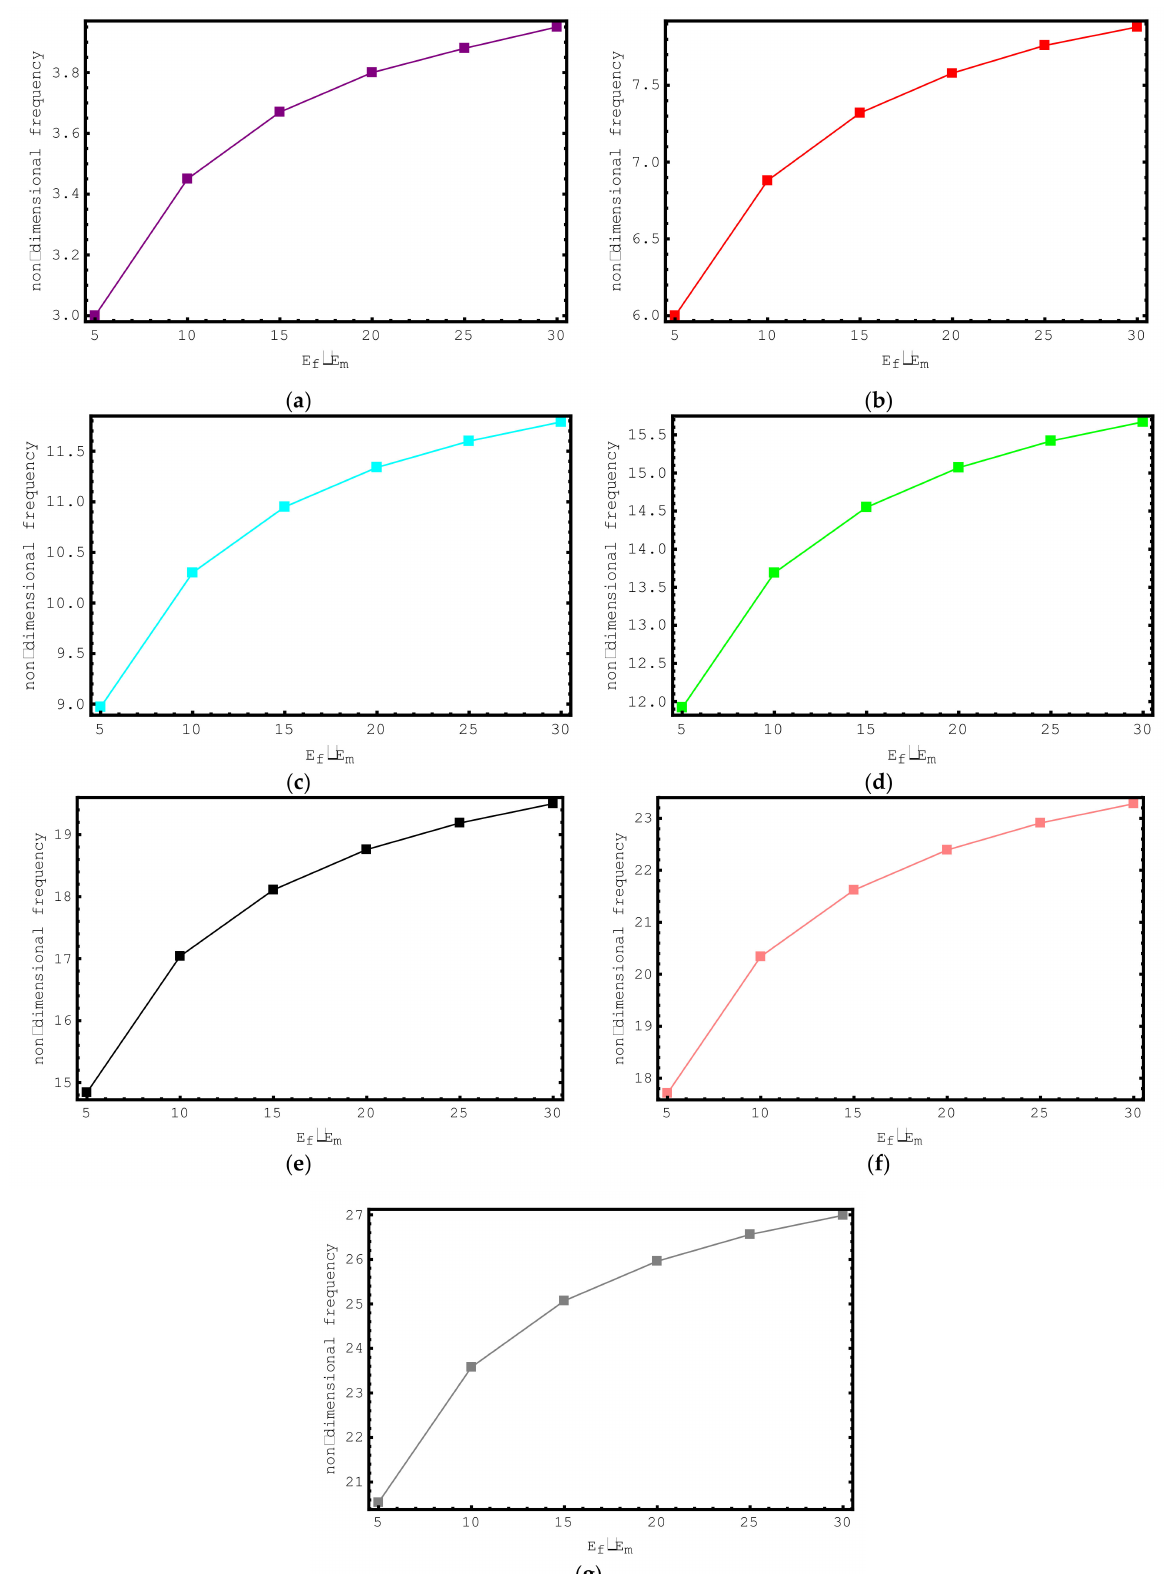
Figure 9. The variations of non-dimensional frequencies of short-fiber-reinforced composite nano- rods versus E f /E m : ( a ) 1st mode ( b ) 2nd mode ( c ) 3rd mode ( d ) 4th mode ( e ) 5th mode ( f ) 6th mode ( g ) 7th